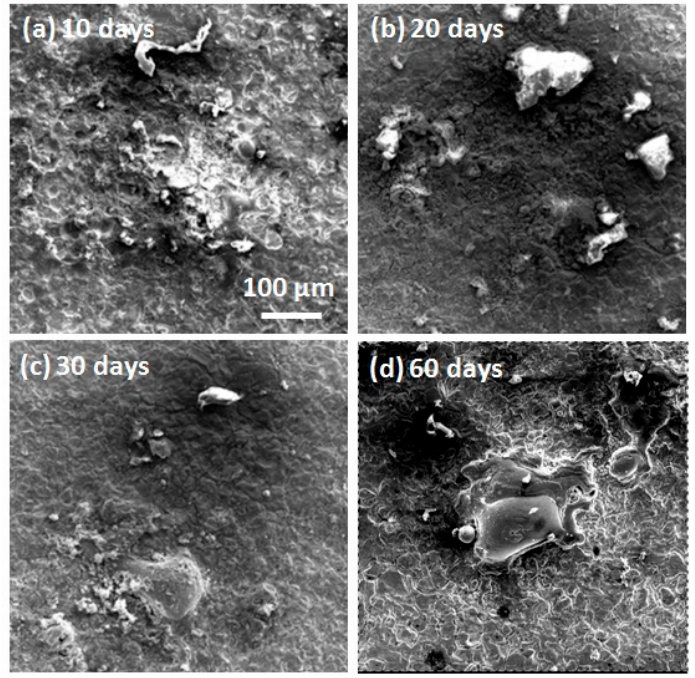
Figure 5. SEM morphologies of 316L over different periods of immersion. ( a ) after 10 days immersion; ( b ) after 20 days immersion; ( c ) after 30 days immersion; ( d ) after 60 days immersion.